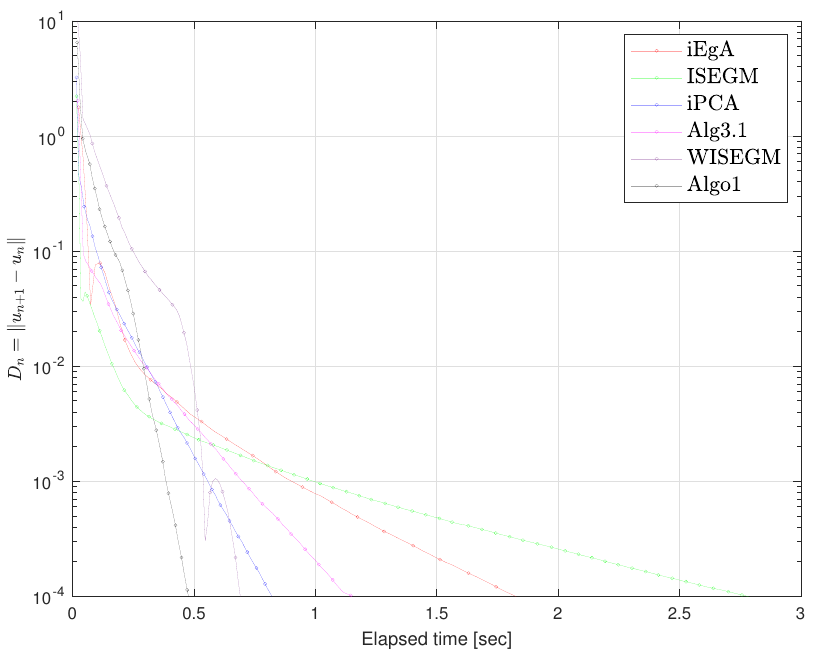
Figure 2. Example 1 in R 5 : Elapsed time 1.83, 2.78, 0.82, 1.25, 0.69, 0.48